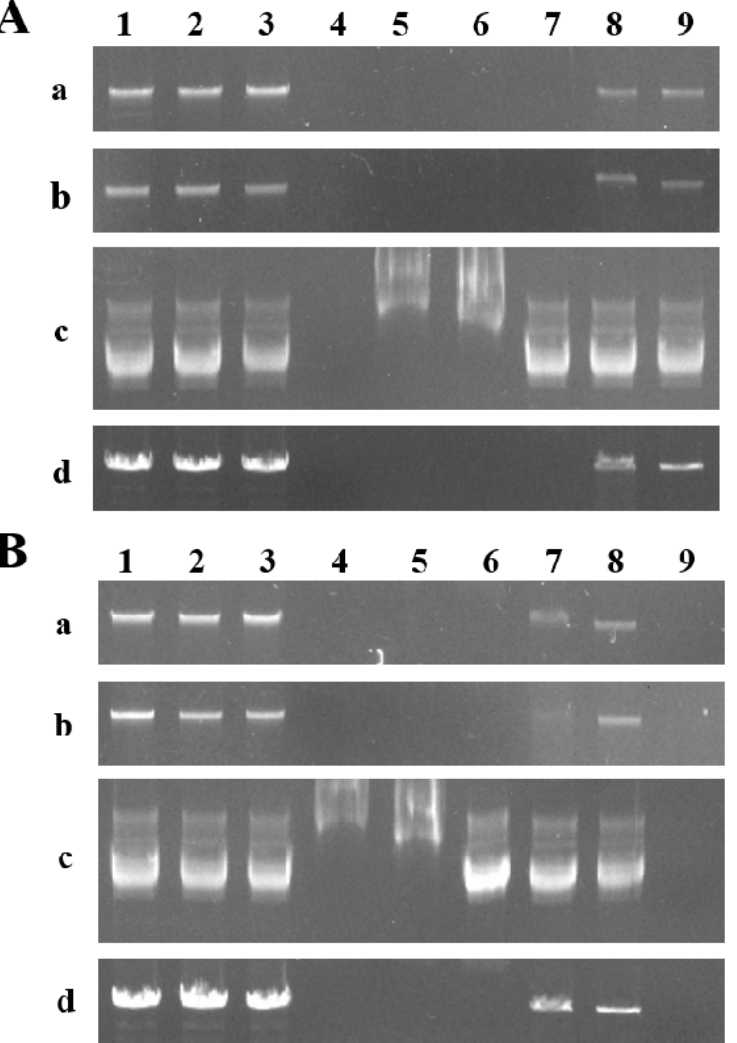
Figure 2. DNase activity analysis of the purified protein GST-CgENDO1 expressed in Escherichia coli . ( A ) The fusion protein CgENDO1 digested DNA with different zinc ions concentrations in vitro